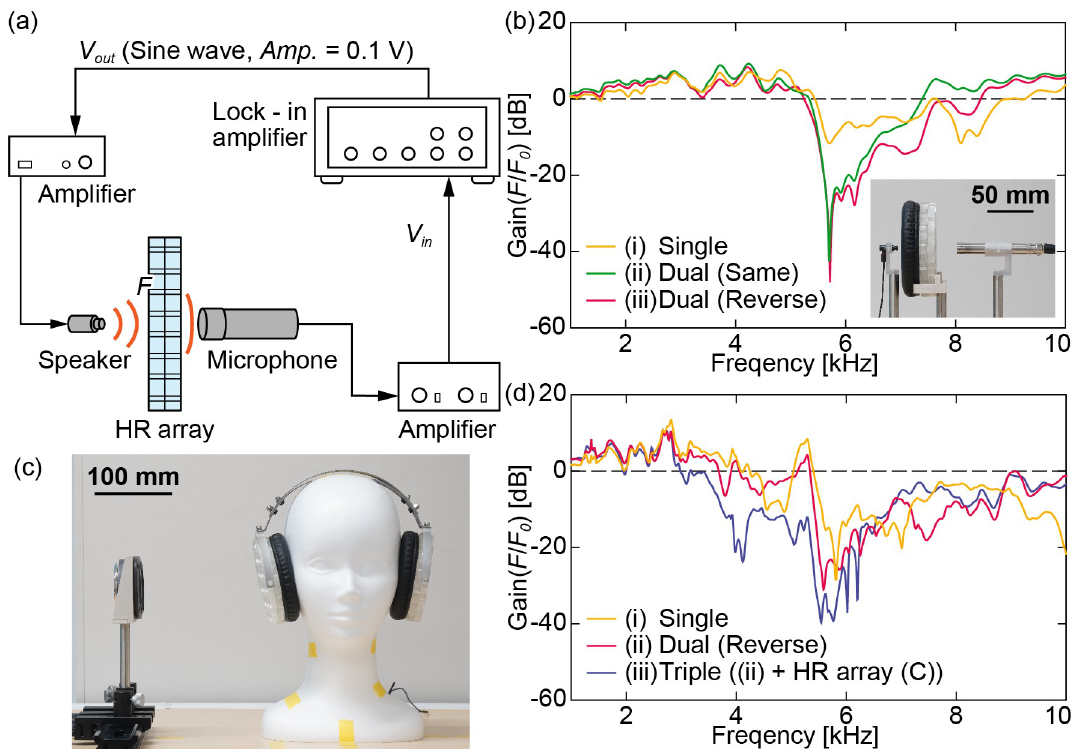
Fig 6. (a) Schematic image of the experimental setup. (b) Results of the experiment with a speaker, a microphone, and HR array plates. The graph shows the experimental frequency responses of the HR array plates. (c) Experimental setup with a speaker, the dummy head microphone, and the HR array earmuff. (d) Results of the experiment with the setup in (c). The graph shows the sound insulation performance of the